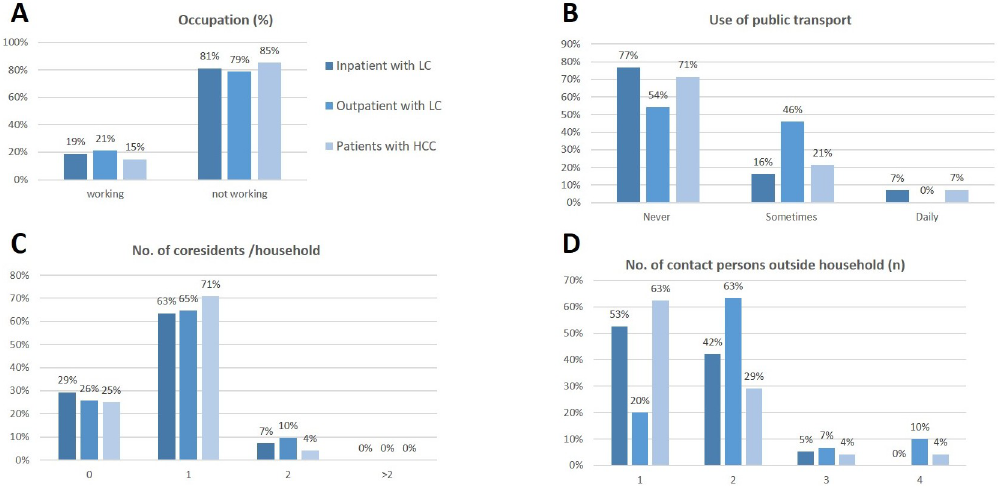
Fig 3. Distribution and frequency of social interactions and risk factors for acquiring viral infection. The majority of patients were not working (A) and only 7% of patients with liver cirrhosis used public transport prior to enrolment (B). Nearly all patients lived together with their spouses or even alone (C), while only 3% of the patients with liver cirrhosis lived together with children in a household. Beside household contacts, patients with HCC had mostly only contact to one person outside the household while patients with liver cirrhosis predominately had contact to two other persons per day. LC: liver cirrhosis.